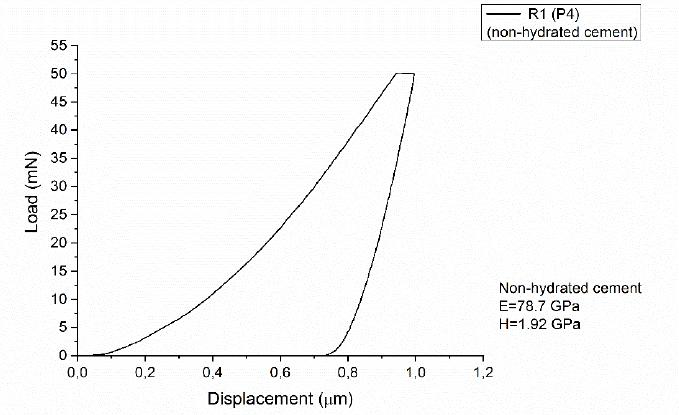
Figure 8. Force versus displacement curve showing particle indentation of non-hydrated cement.